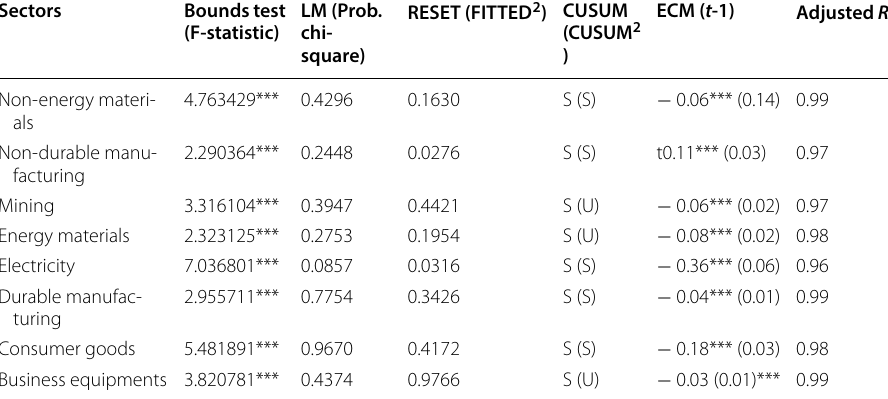
Table 4 Diagnostic tests for NARDL